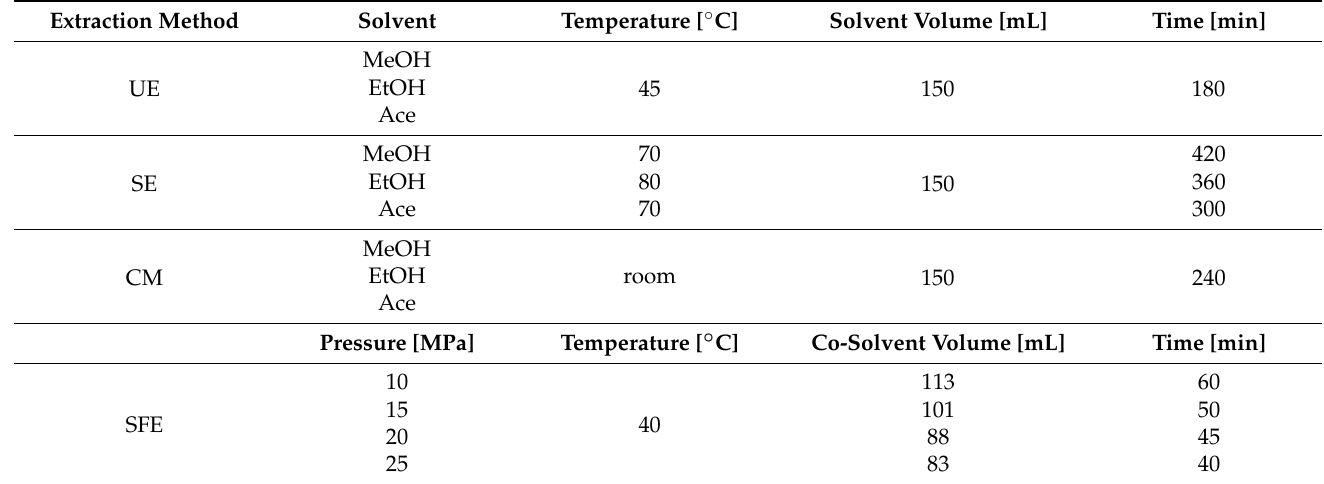
Table 5. Operating conditions for extractions of lyophilized